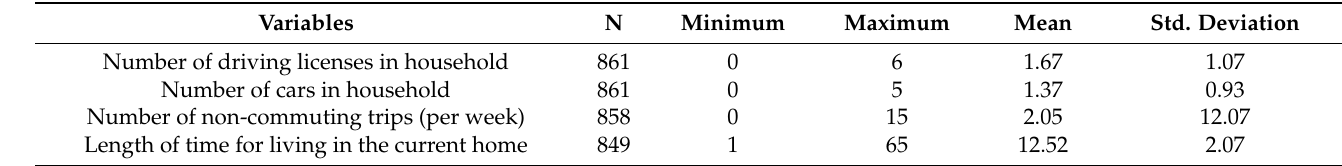
Table 2. Descriptive statistics of continuous variables in the